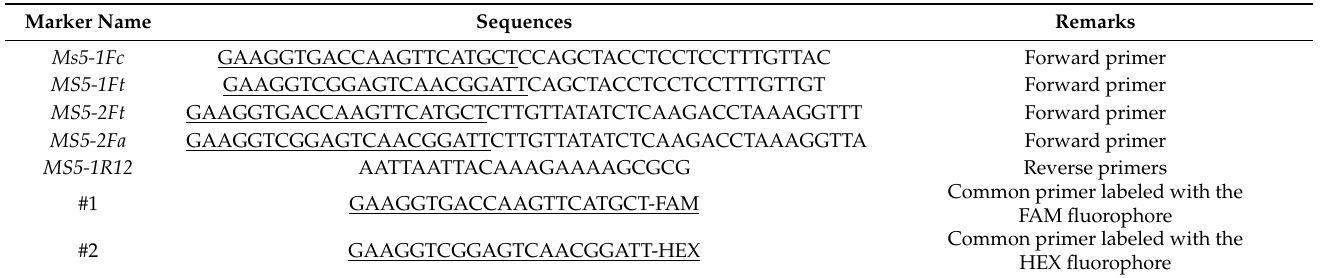
Table 1. The PARMS markers used in the detection of BnMS5 a , BnMS5 c and BnMS5 e